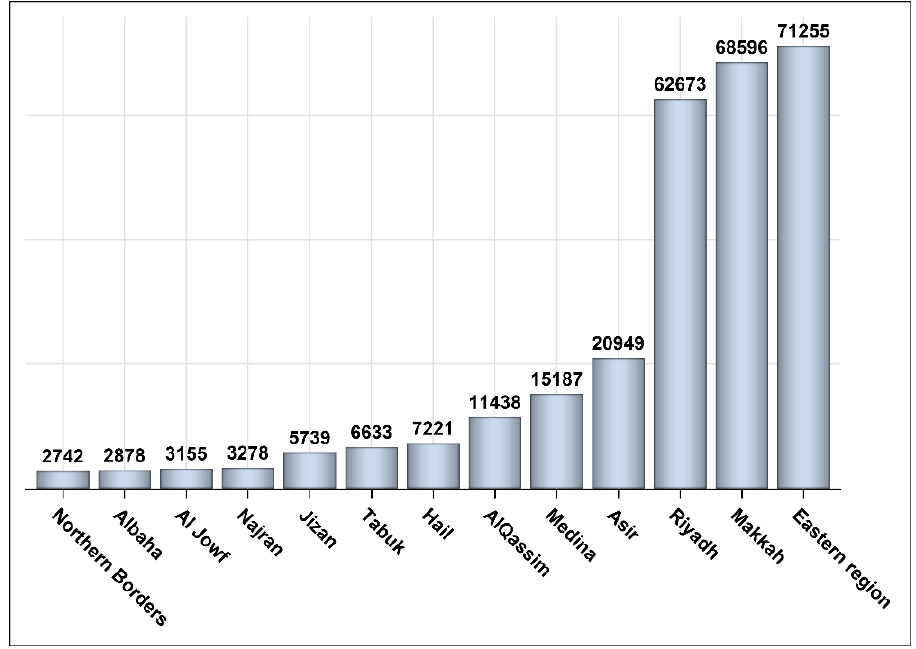
Figure 1. Schematic diagram of sample recruitment.